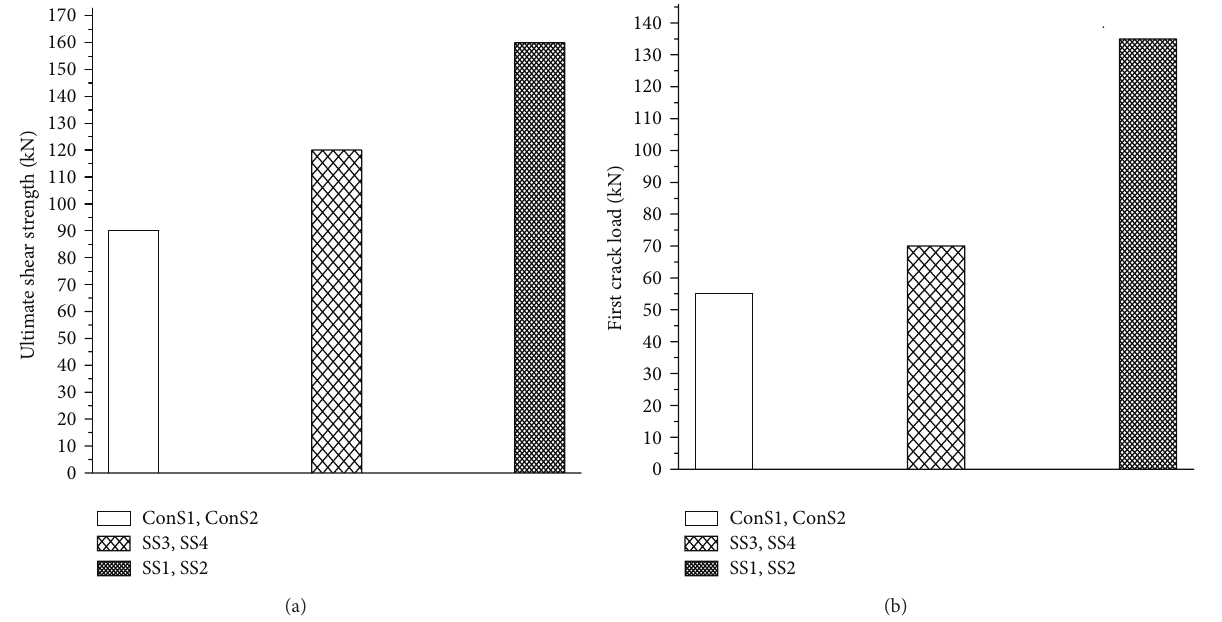
Figure 10: (a) comparison of ultimate shear strength of all beams; (b) comparison of first crack load of all